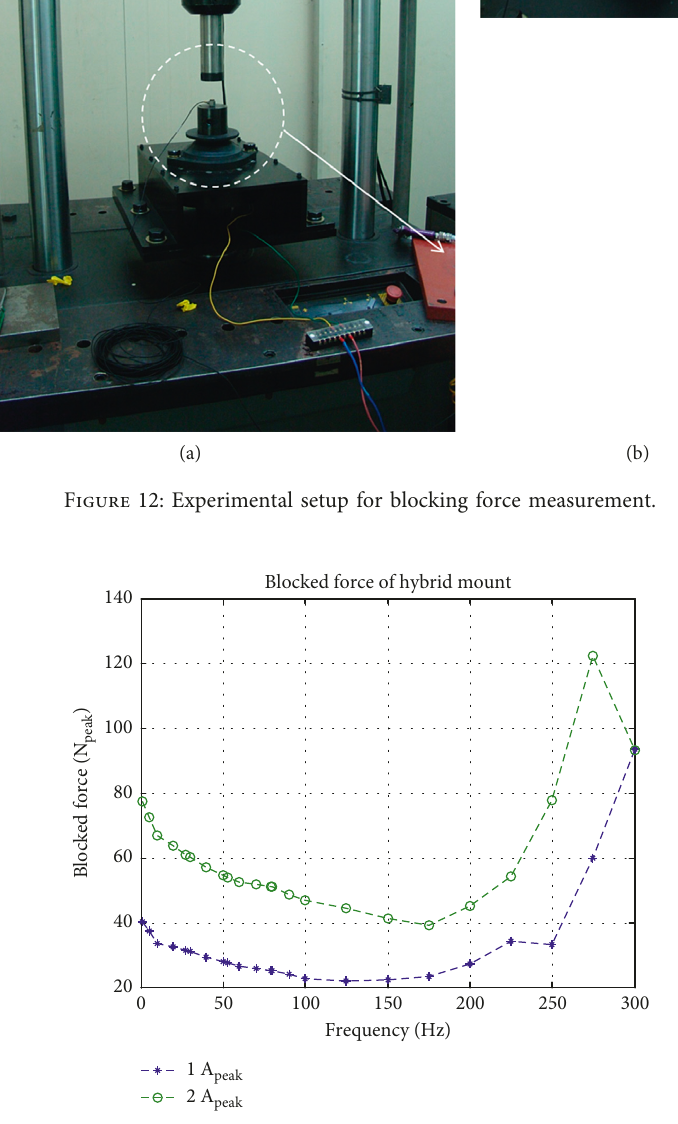
Figure 13: Measurement of blocking force for modified electromagnetic